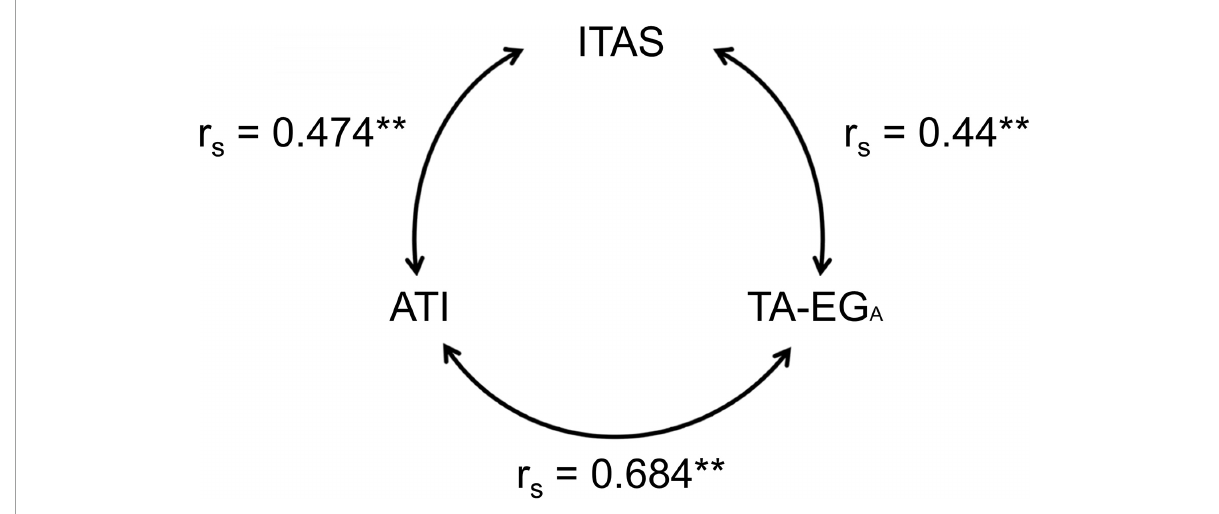
FIGURE5 Correlations according to Spearman’s rank correlation (r s ) between the technology affinity scales (ATI; TA-EG A ; ITAS) used in study 2. **Significant at the level p < 0.01.